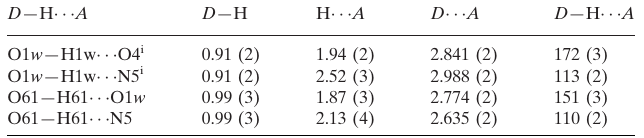
Hydrogen-bond geometry (A˚ , (cid:3)